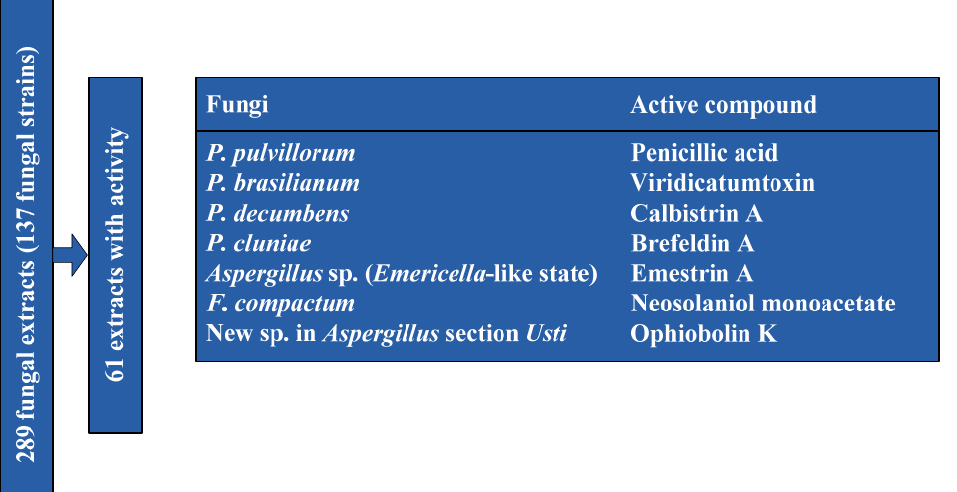
Figure 1. Screening set-up. Two hundred and eighty nine (289) fungal extracts (from 137 fungal strains) were tested for cell death-inducing activity for CLL cells but not for stromal cells. From the 61 active extracts the seven candidates that displayed the highest bio-assay activity were selected for single compound isolation in a large scale and further bio testing.